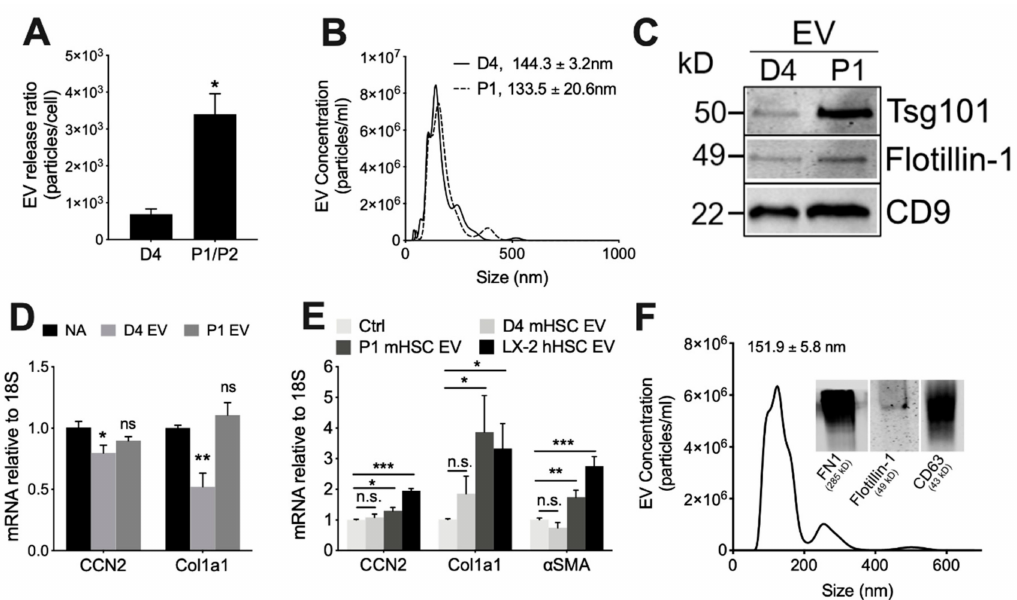
Figure 2. Characterization of EVs from mouse HSC. NTA was performed on EVs that had been purified by di ff erential centrifugation of 2-day serum-free conditioned medium from D4 HSC or P1-P2 HSC, with particle number expressed as a function of ( A ) cell number or ( B ) particle size (mean ± S.E.M. for particle diameter (nm) is indicated). ( C ) Western blot analysis of D4 or P1 EVs (25 µ g EV protein per lane) showing the presence of common EV proteins. ( D ) P1 HSC or ( E ) D4 HSC were treated for 48 h with 8 µ g / mL EVs from D4 mHSC, P1 mHSC or LX-2 hHSC after which expression for the